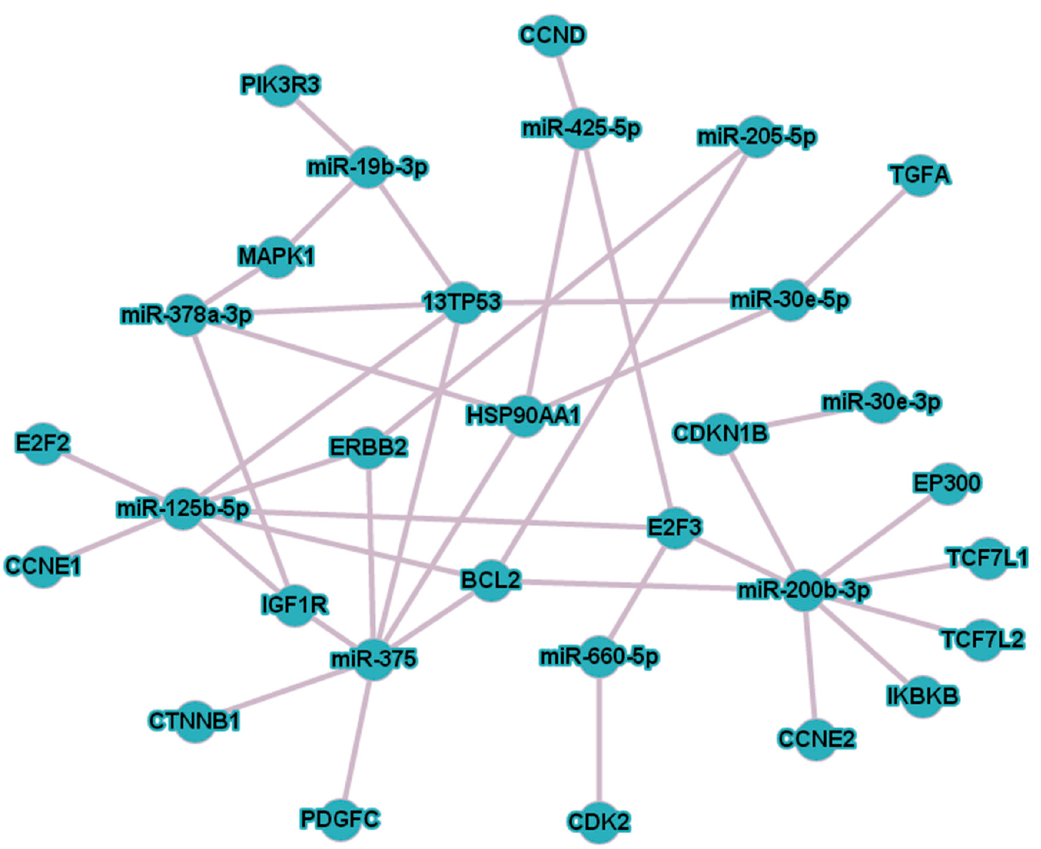
Figure 7. The altered expression of the miRNAs after RP and their target genes responsible for “cellular proliferation” and “biologic regulation” (according to the PANTHER database) visualized using the miRnet database.